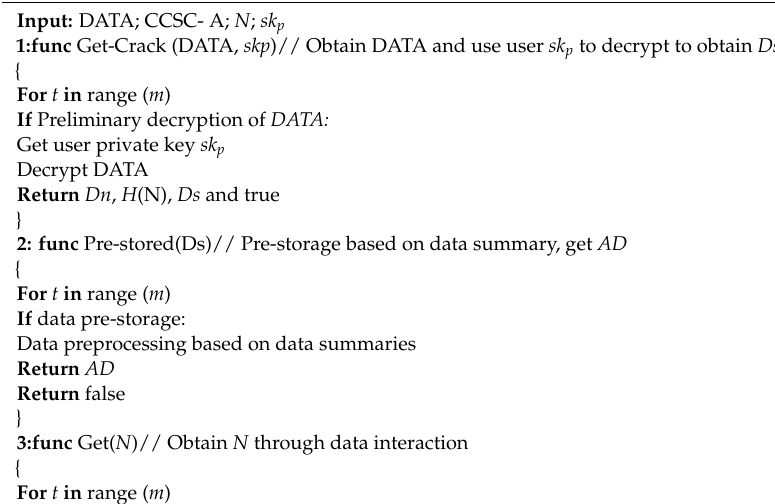
Algorithm A2: Collect cross-chain smart contract